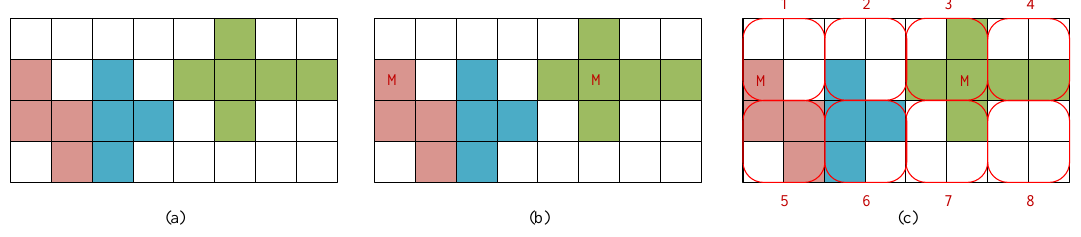
Figure 1. An example of fuzzy superpixel-based sample selection. ( a ) Superpixels segmented by using the Fs algorithm. ( b ) Labeled superpixels and unlabeled superpixels. ( c ) Sample